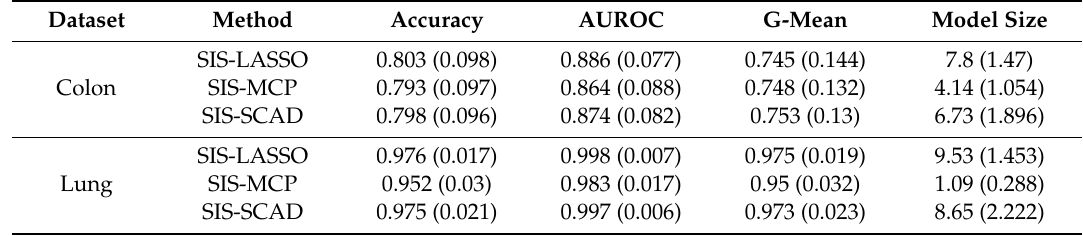
Table 3. Classification performance of the proposed selection method with SIS-LASSO, SIS-MCP, and SIS-SCAD in both colon and lung cancer. It is the average performance resulting from 100 iterations.